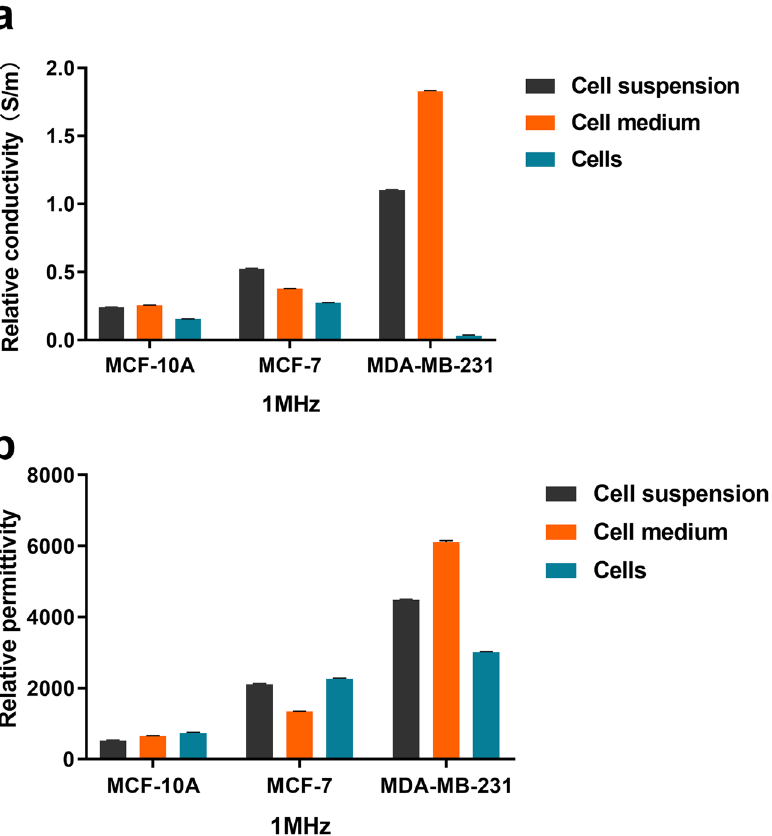
Figure 2. Comparison among the σ and ε of the three types of cells, cell media, and cell suspensions at 1 MHz. ( a ) Comparison among σ. ( b ) Comparison among ε. (Data are means ± SD, n =